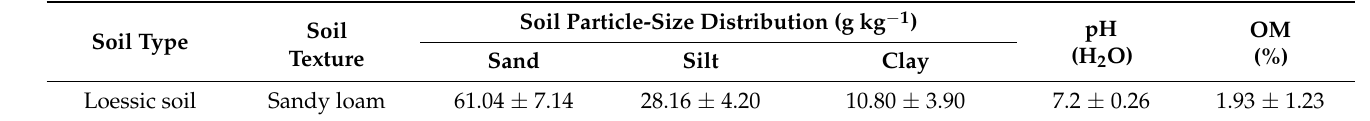
Table 1. Soil basic information in this study.